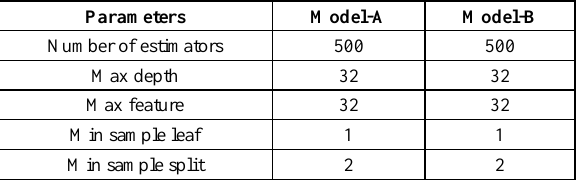
Table 2 . Optimal parameters of RF models.